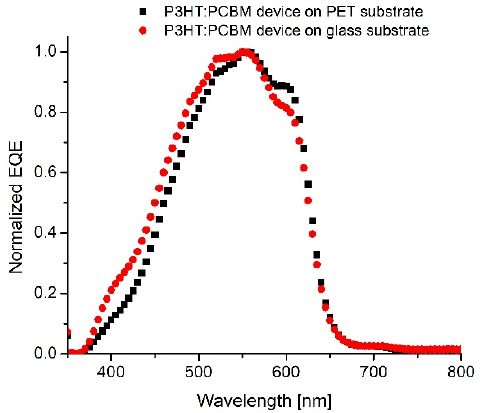
Figure 2. External quantum efficiency spectrum of solar cells.